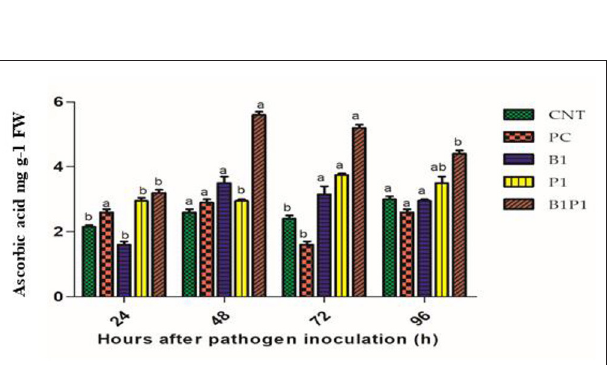
FIGURE 8 | The development of blue-to-violet-colored formazan on the petiolar and in the interveinal part of leaf by the reduction of tetrazolium dye. (A) Control, (B) B1P1, and (C) PC.